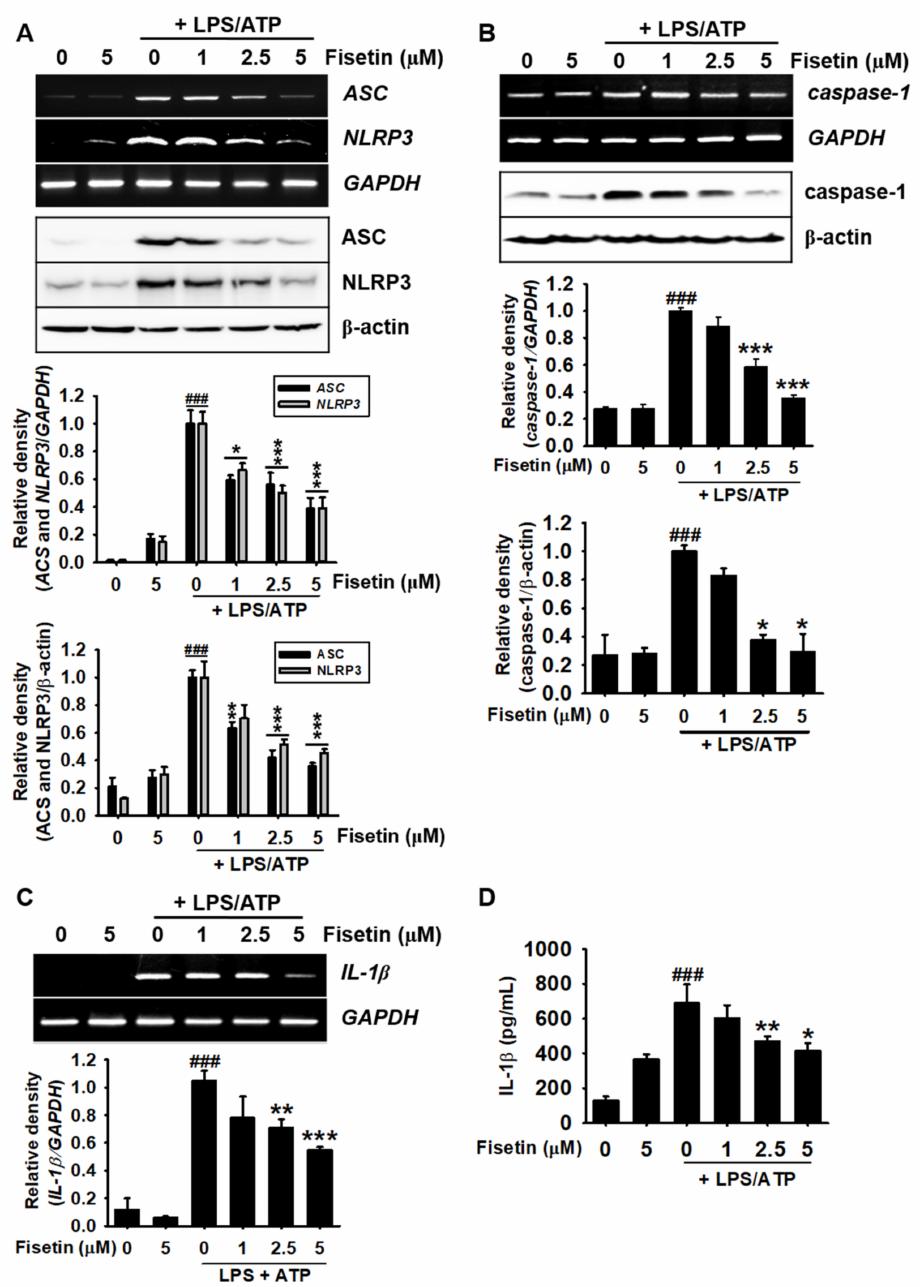
Figure 4. Fisetin inhibits the maturation of IL-1 β by suppressing the formation of the NLRP3 inflammasome. BV2 microglial cells were treated with the indicated concentrations of fisetin (0–5 µ M) for 2 h prior to stimulation with 1 µ g/mL LPS for 2 h and subsequent stimulation with 1 mM ATP (LPS/ATP). ( A – C ) Total RNA was extracted after 9 h of treatment and total proteins were extracted after 18 h, following which RT-PCR ( top ) and western blotting ( bottom ) were performed. Relative densities were calculated using ImageJ software. ( D ) In a parallel experiment, cell culture media were collected after 48 h and the extracellular levels of IL-1 β were quantified using ELISA. The results indicate the mean ± standard error median (SEM), and is representative of the results obtained from three independent experiments. ### p < 0.001 vs. untreated cells; *** p < 0.001, ** p < 0.01, and * p < 0.05 vs. LPS/ATP-treated